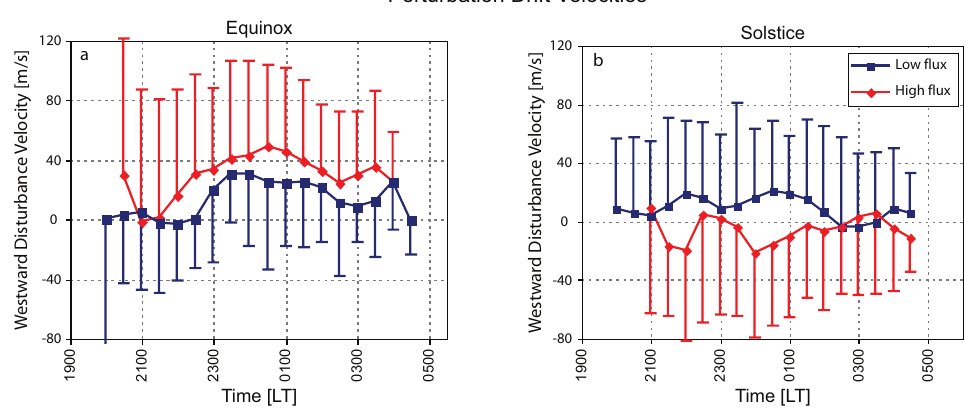
Fig. 6. Westward perturbation drift velocities, calculated by subtracting zonal drifts during geomagnetically disturbed conditions from quiet time drifts, organized by solar flux level and season. In this figure positive numbers denote westward